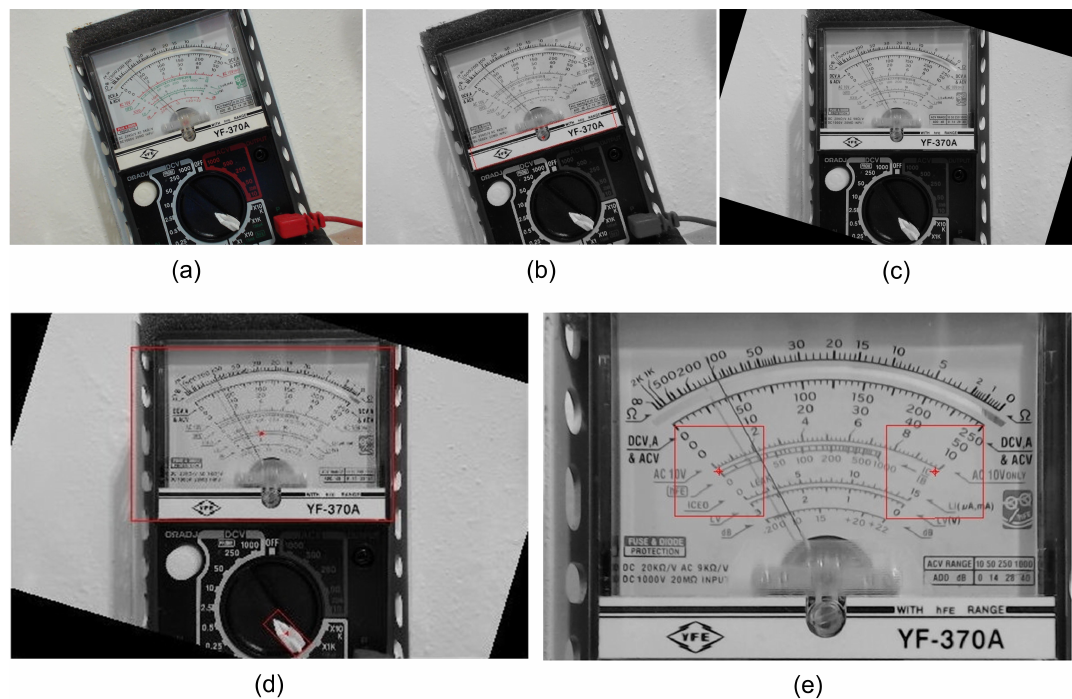
Figure 12. ( a ) The acquired image ( I org ) from measuring the 1K Ω resistor by the A-meter YF-370A, where the gray channel of I org was used for further processing. ( b ) Rotation A-meter = 16.914 ◦ obtained by Equation (8). ( c ) Horizontal alignment image ( I adj ) obtained by rotating I org in ( a ) minus the rotation A-meter . ( d ) The instrument meter region ( R IM ) detected by means of Equation (12) with the templates given in Figure 7a–c, whereas the selector arrow was detected by Equation (13) with the template given in Figure 8. ( e ) Within the found R IM , the useful right-end R right-end and left-end R left-end of the scale were detected by means of Equation (12) with the templates given in Figure 7d–f,g–i, respectively.